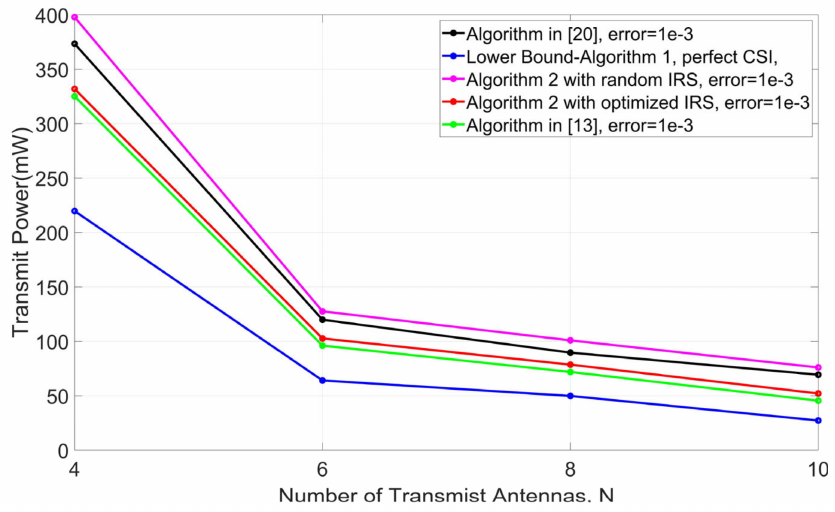
Figure 4. Effectiveness of the proposed algorithm under different numbers of the